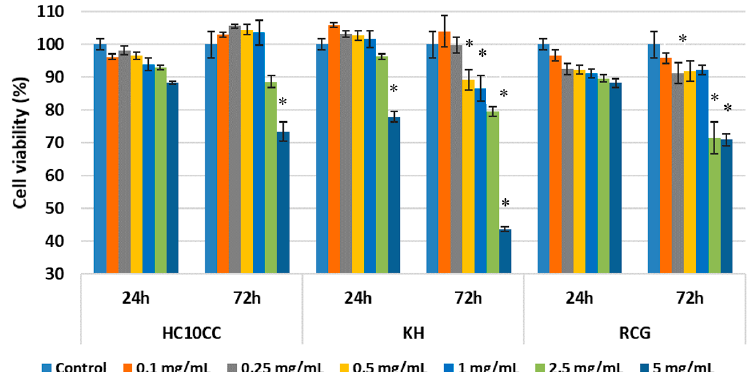
Figure 6. Viability of L929 mouse fibroblasts cultivated in the presence of electrospun HC10CC, KH, and RCG nanofibers for 24 and 72 h, evaluated by the MTT assay. Samples were reported to untreated cells (control) considered to have 100% viability. Data were expressed as mean values ± SD (n = 3). * p < 0.05, compared to the control.